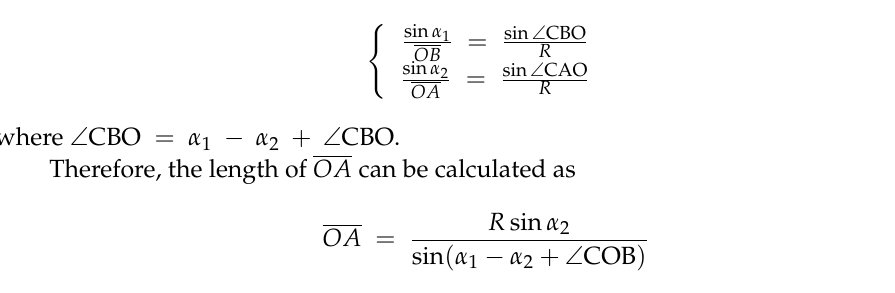
Figure 2. Diagram of the HL. Table 1. Parameters of CPC.